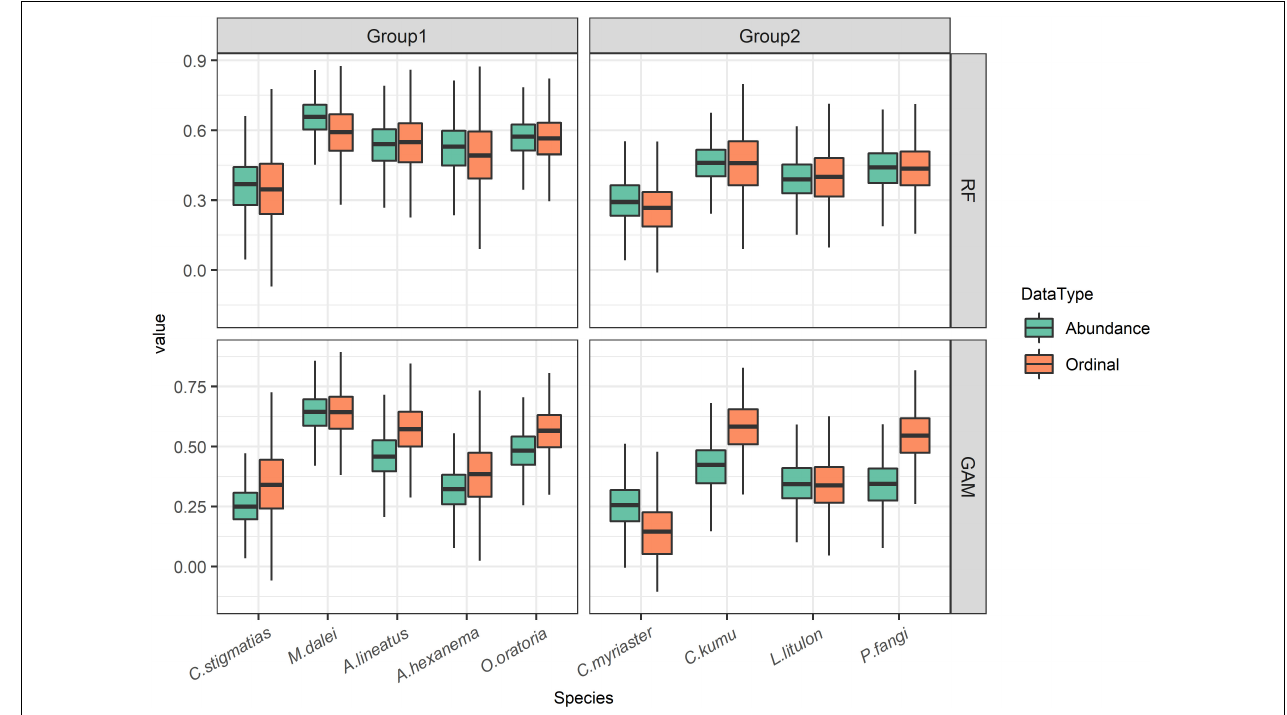
FIGURE 5 | The accuracy metric (weighted Kappa) of models trained with two data types in terms of predicting abundance grades.